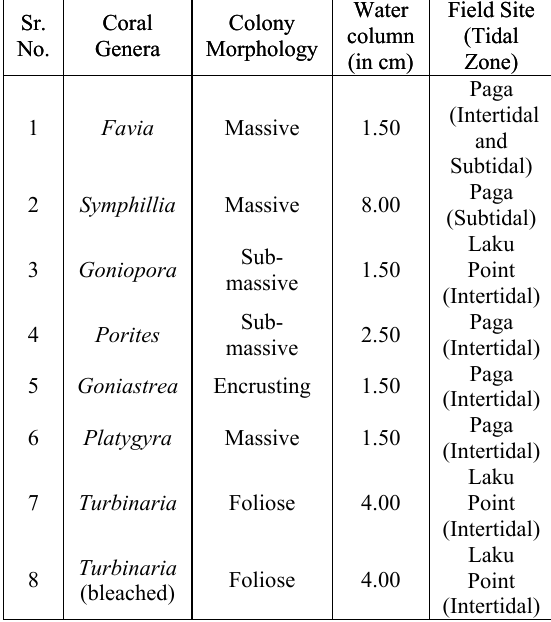
Table 1. Details of the eight sampled coral targets